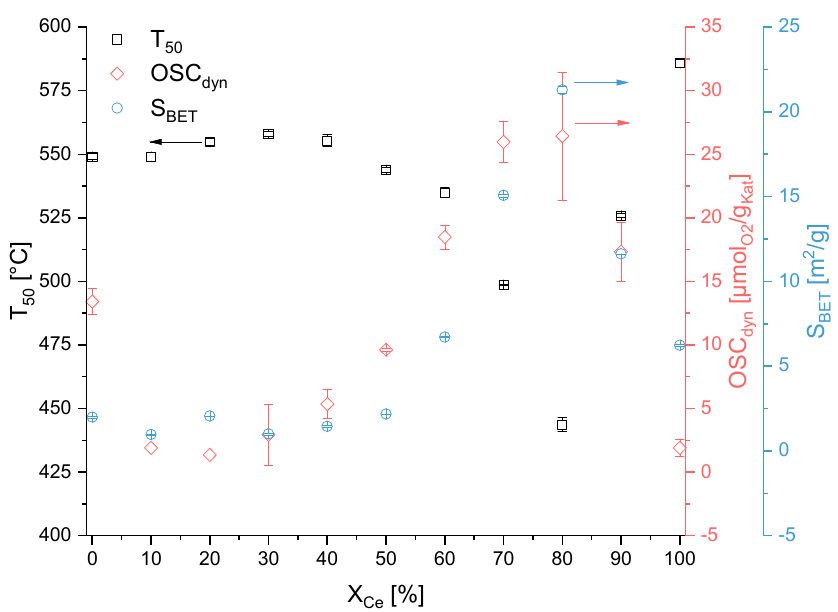
Figure 5. T 50 (tight contact), S BET and OSC dyn values in dependence of the nominal molar Ce content for samples prepared by reverse strike precipitation. Shown are duplicate measurements with their standard deviation.